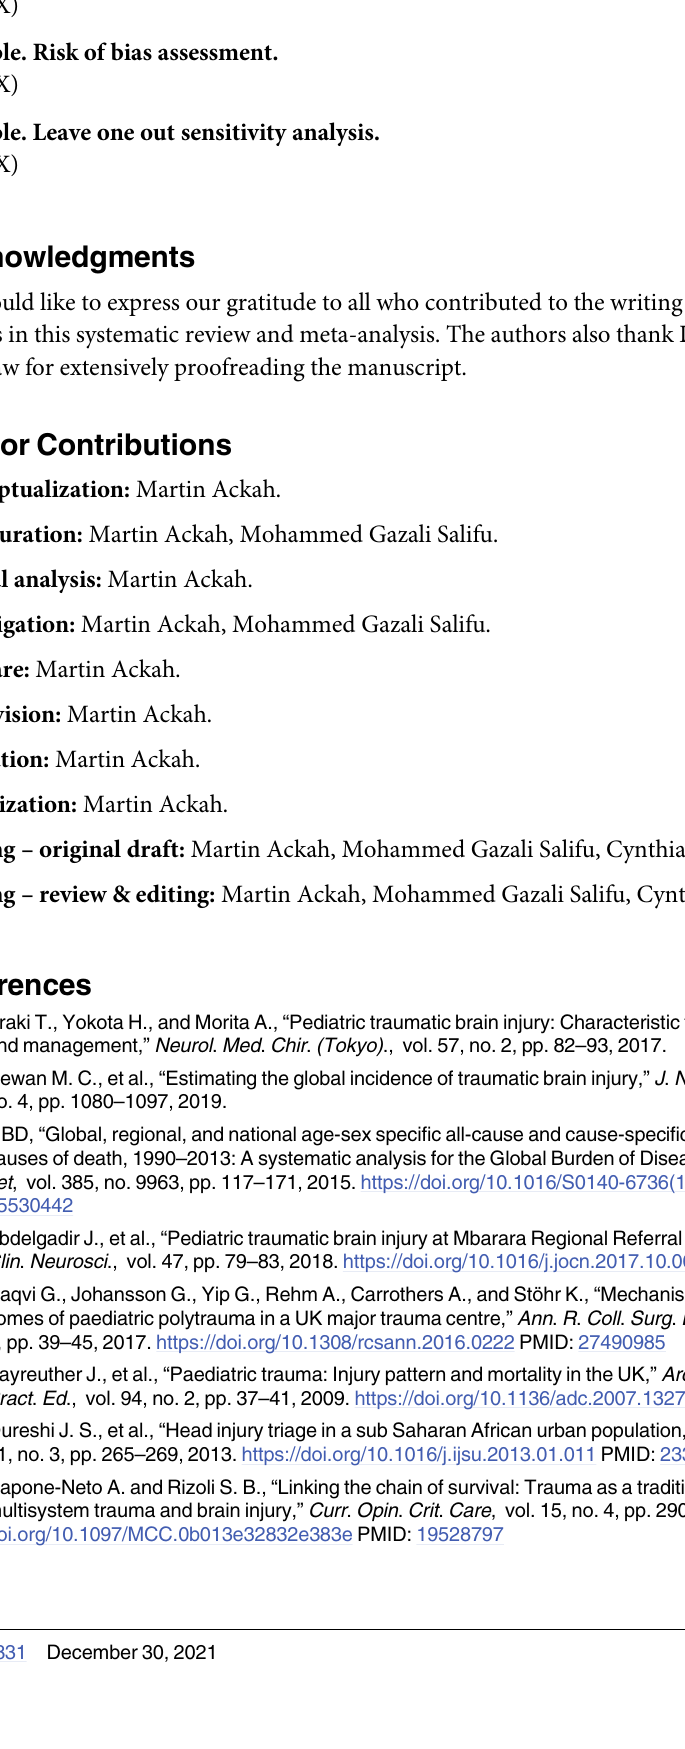
S2 Table. Search strategy for the databases. S3 Table. Risk of bias